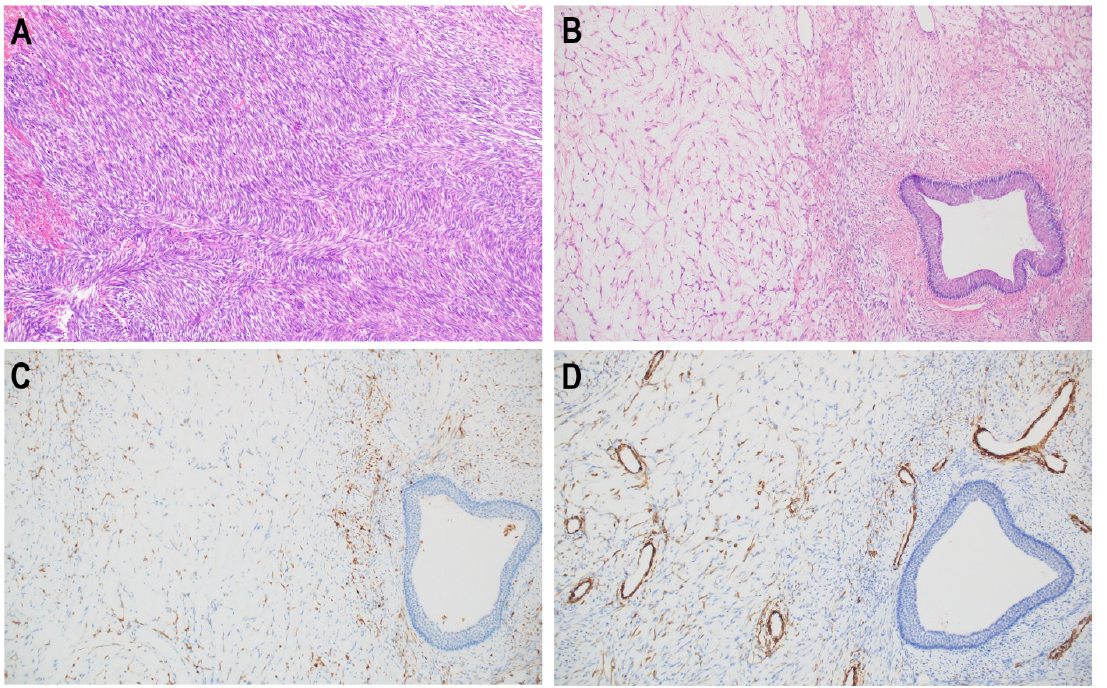
Figure 1. Low-power appearance of BSNS. Predominantly BSNS is a highly cellular, monotonous, bland-appearing spindle cell proliferation, arranged in medium to long fascicles often with prominent herringbone architecture ( A ). One case presented different morphology with prominent myxoid features ( B ). Myxoid component also showed expression of S100 ( C ) and SMA ( D ).